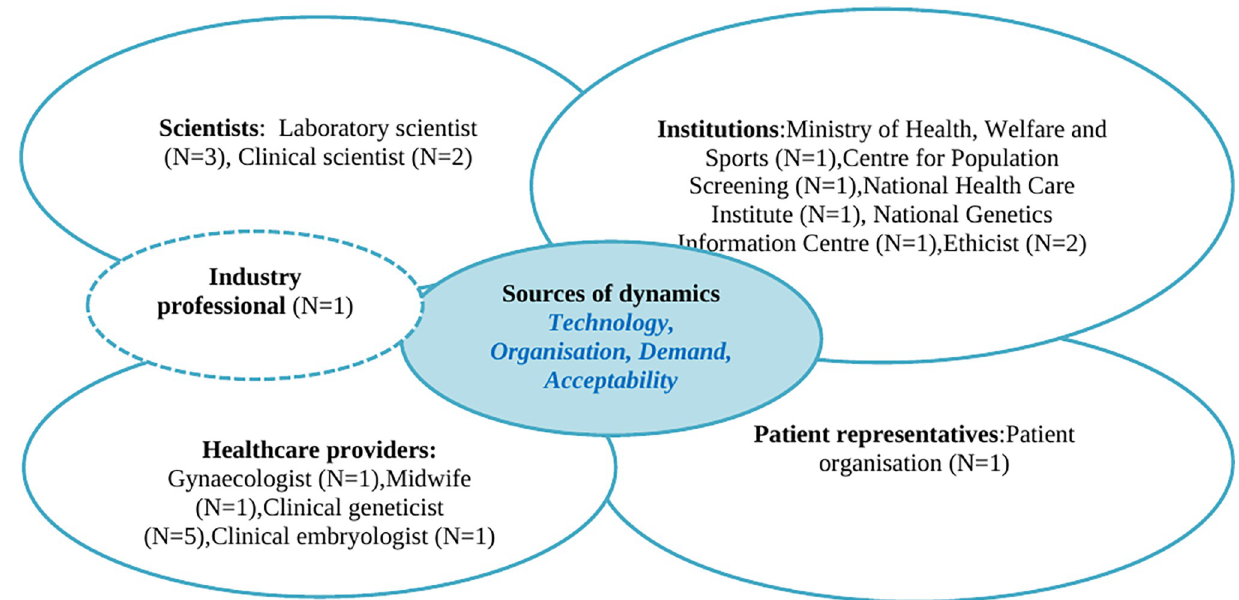
Fig 2. Network of Actors model, adapted from Achterbergh et al. [26]. The numbers of interviewees per stakeholder group are indicated with N = x.